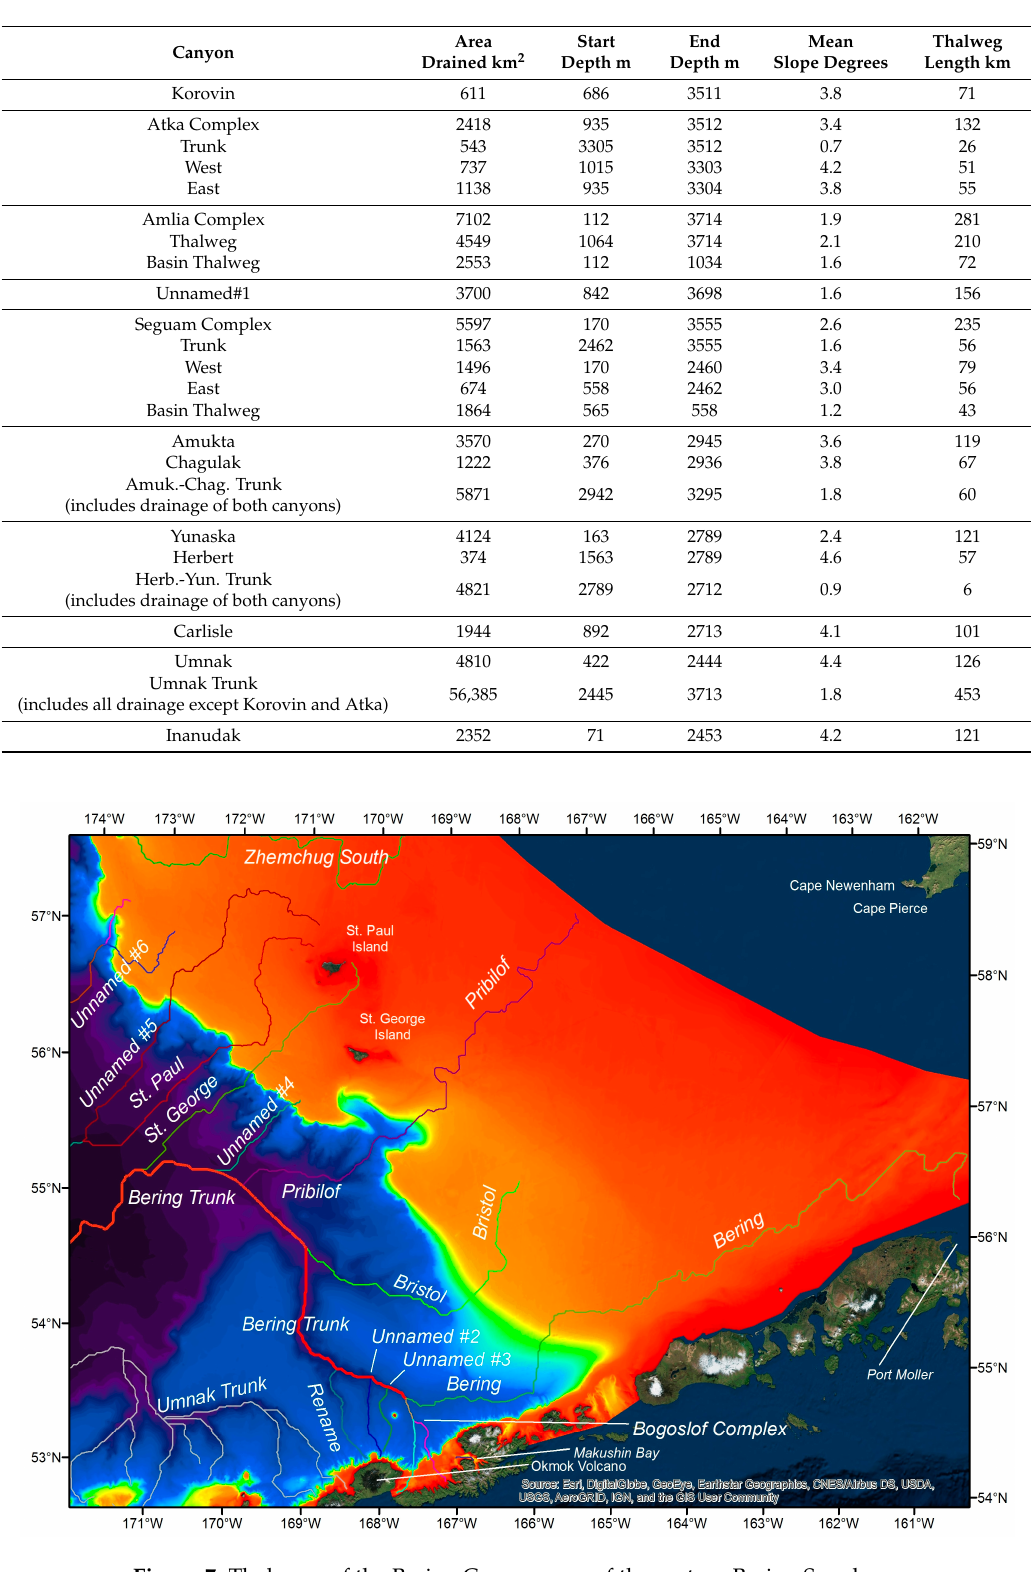
Table 1. Umnak Canyon names and metrics described from west to east.